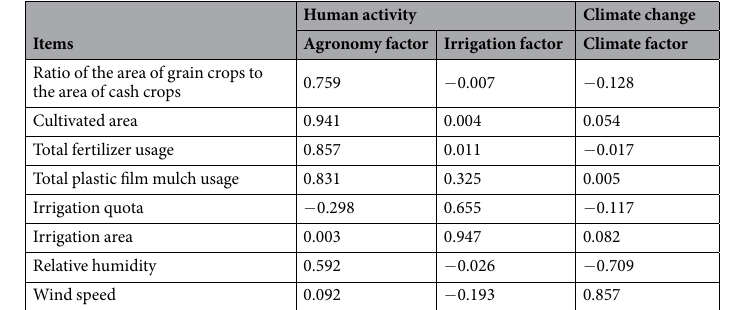
Table 6. Rotated component matrix in factor analysis of total